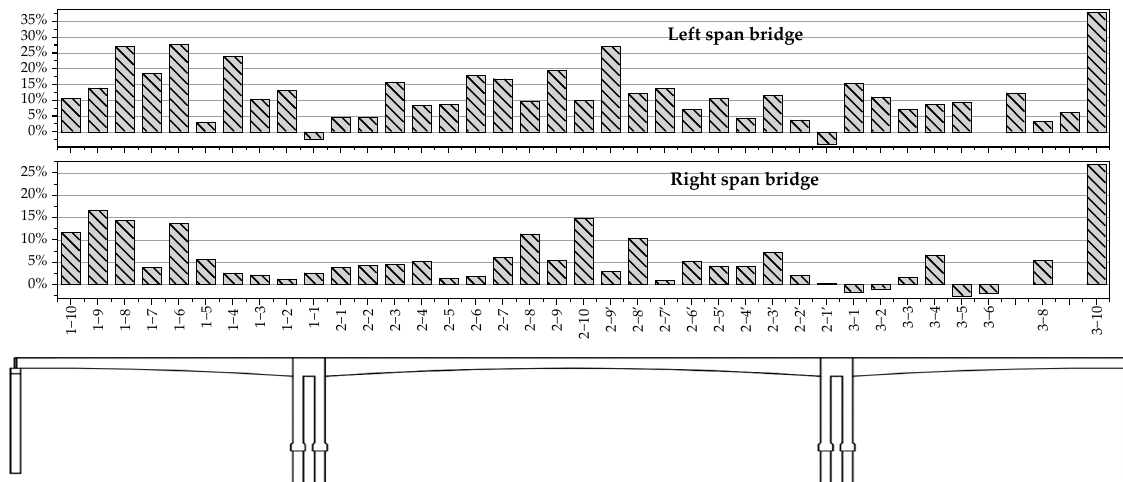
Table 4. Statistical analysis of 𝐾 (cid:3036) of bridge A and bridge B. Figure 11. Deviation-rate bar chart of the bridge B cross sections. Figure 11. Deviation-rate bar chart of the bridge B cross sections.